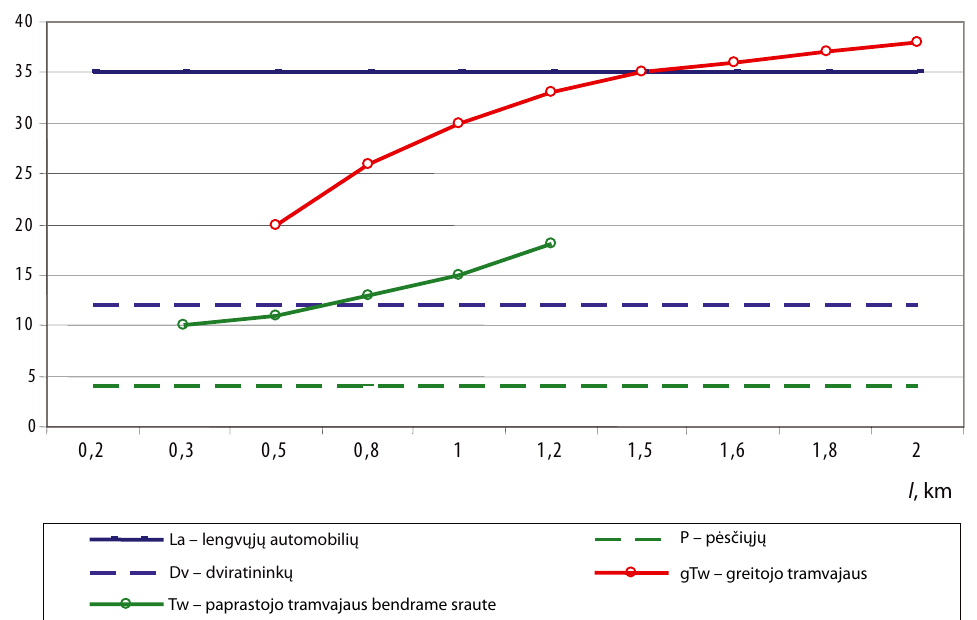
6 pav. Paprasto ir greitojo tramvajaus važiavimo greičių priklausomybės nuo tarpstočių ilgio. Palyginimui – kiti važiavimo, ėjimo vidutiniai greičiai Fig. 6. Dependence of speed of ordinary and fast tram on distance between stops in comparison with average rates of other vehicles and walking